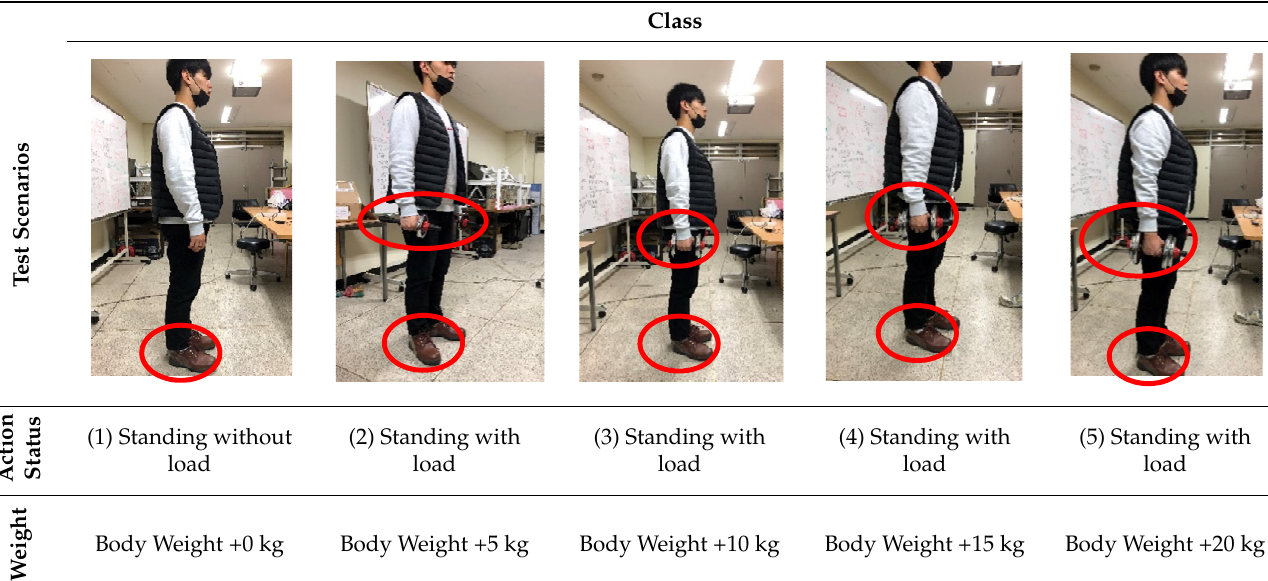
Table 1. Heavy object transport experiment for weight estimation.